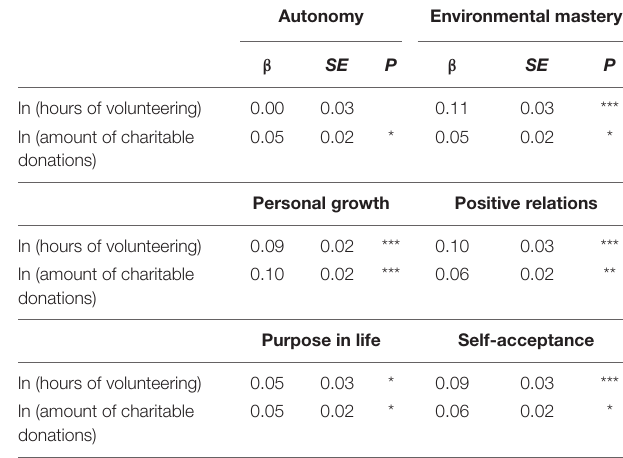
TABLE 3 | Regression analysis of psychological well-being